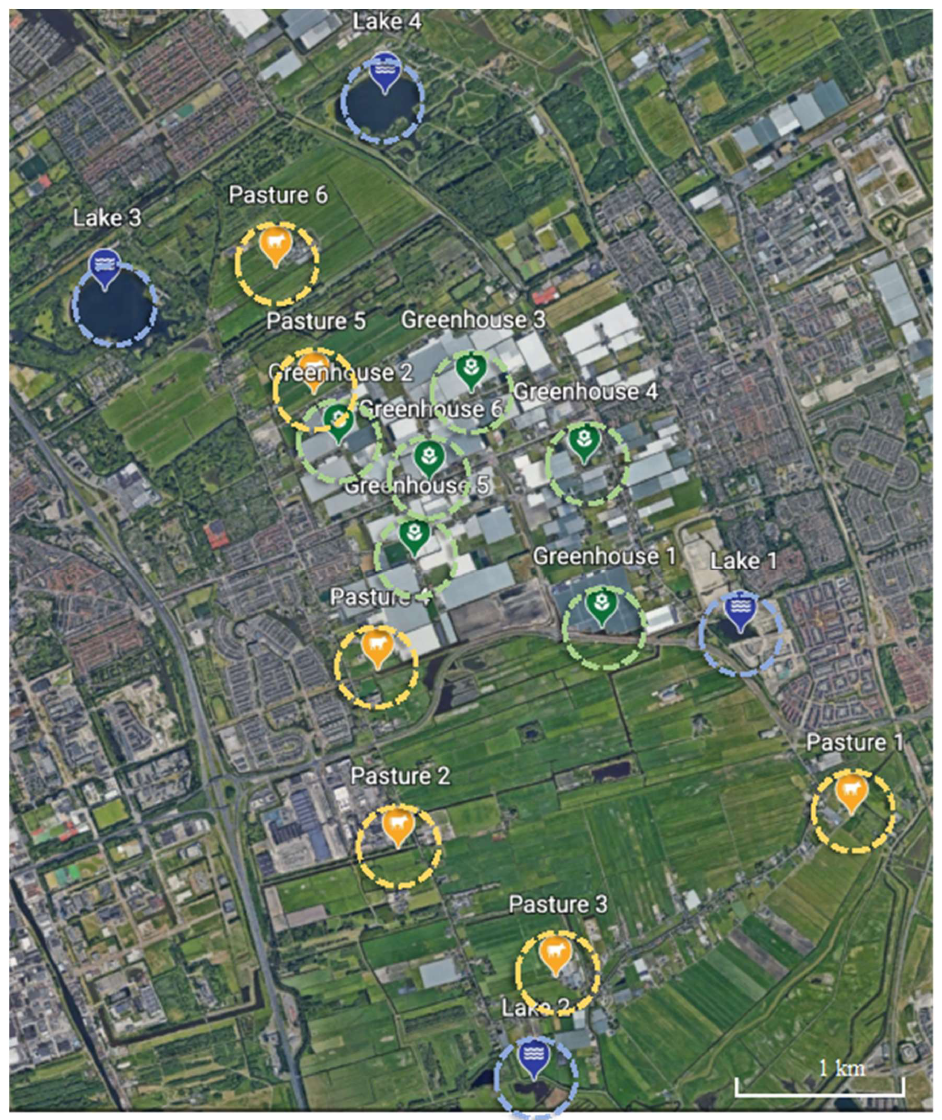
Figure 1. Sampling locations. The colors indicate the location types, including pasture (yellow), greenhouse (green) and lake (blue). Each location is highlighted by a circle with a diameter of 500 m to indicate the zone of immediate influence on the sampling